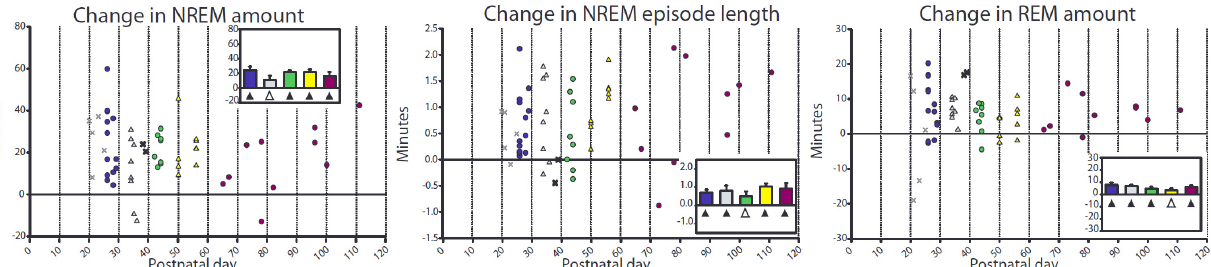
Figure 5. Changes in sleep duration after sleep deprivation. Each faint “X” denotes a mouse that underwent a 2 h deprivation and is included only as a reference. Left and middle panels show the difference (in min) in NREM amount and NREM episode length during the first 4 h of recovery sleep (starting at noon) relative to the first 4 h of baseline sleep (starting at 8 a.m.), while the right panel shows changes in REM amount during the first 8 h of recovery sleep (from noon until lights-off at 8 p.m.) relative to the first 8 h of baseline sleep. Triangles indicate group mean different from 0 (paired 2-tailed t -test; filled symbols p < 0.05, empty symbols p <